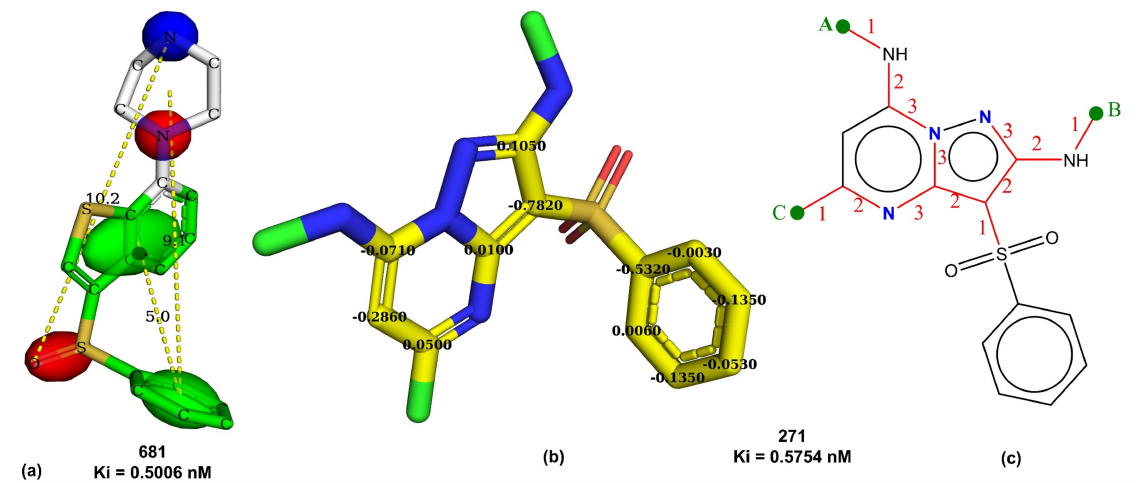
Figure 9. Depiction of ( a ) pharmacophoric feature using molecule 681 (green: hydrophobic, red: H-bond acceptor, blue: H-bond donor regions, dotted lines show distances in Angstrom units), ( b ) yellow atoms represent ringC_S_4Bc in molecule 271, ( c ) fliporingN3B represented by red-colored bonds with numbering using molecule